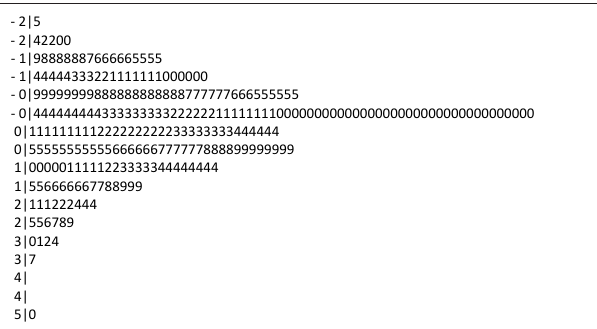
FIGURE 1: The stem leaf plot.